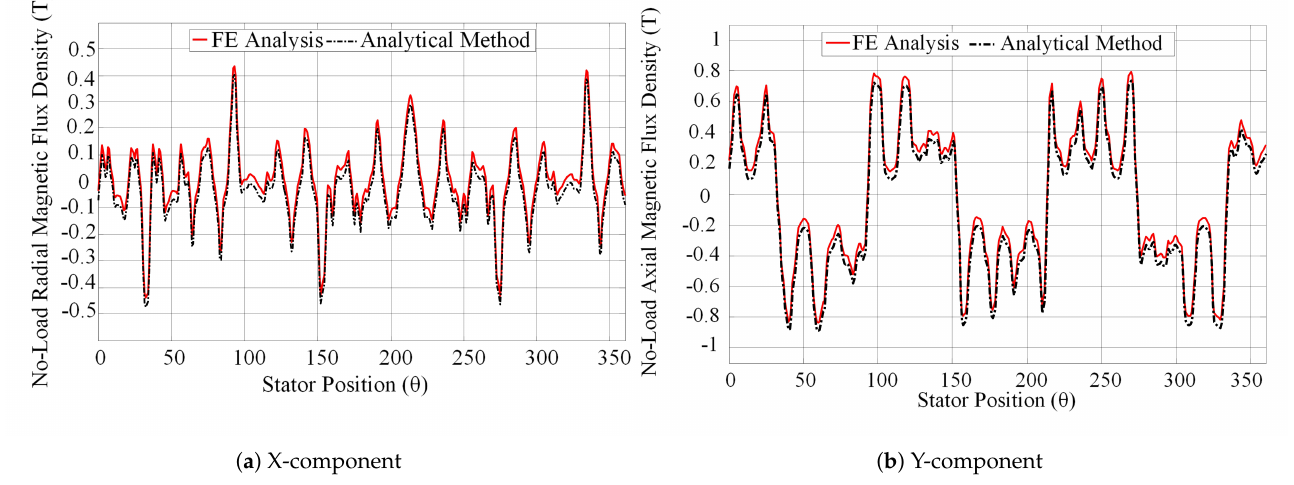
Figure 14. No-Load flux density comparison at y = g/2 (Air